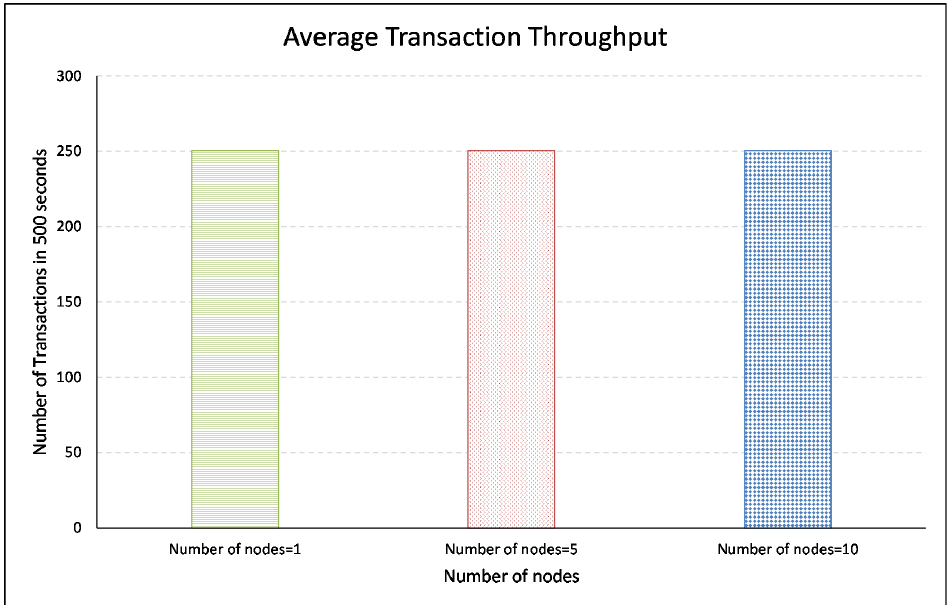
Figure 11. Average transaction throughput in